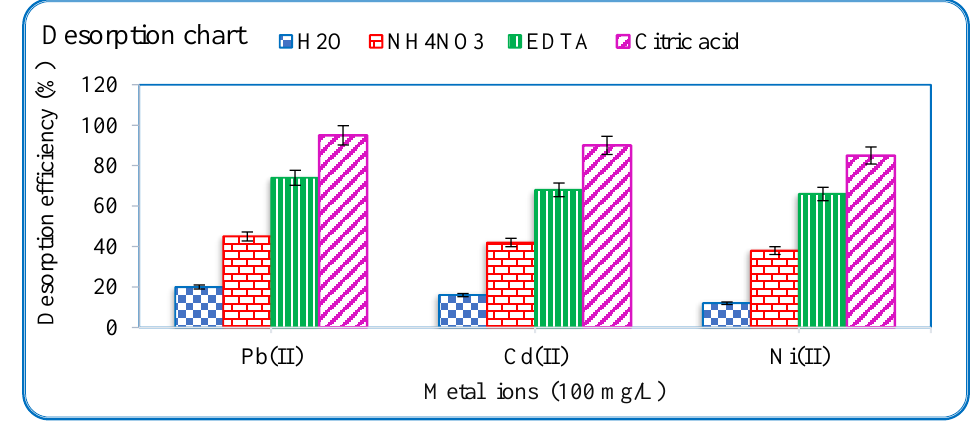
Figure 10. Desorption efficiency (%) of metal ions (100 mg/L for each) biosorbed by immobilized S. cerevisiae yeast cells by H 2 O, NH 4 NO 3 , EDTA, and citric acid. Error bars represent standard